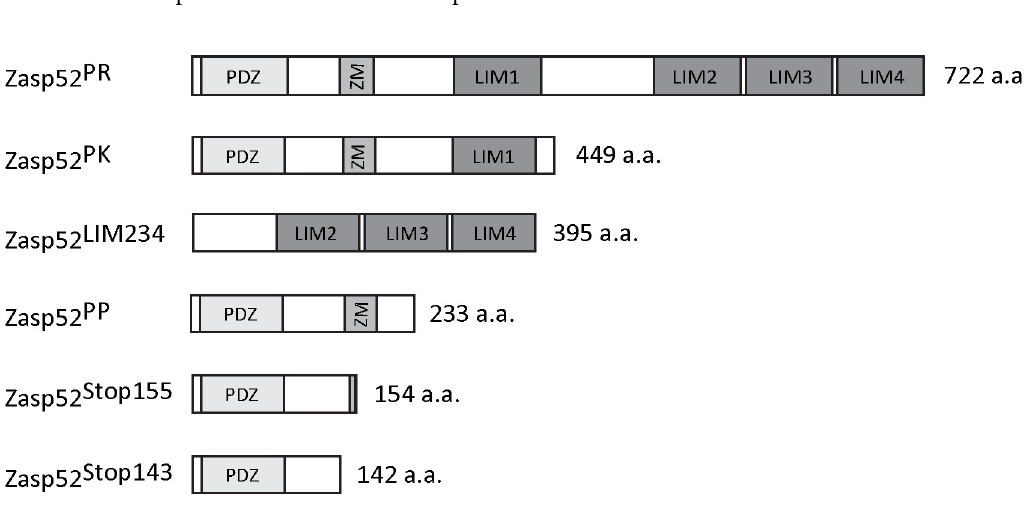
PLOS ONE | https://doi.org/10.1371/journal.pone.0232137 July 2,